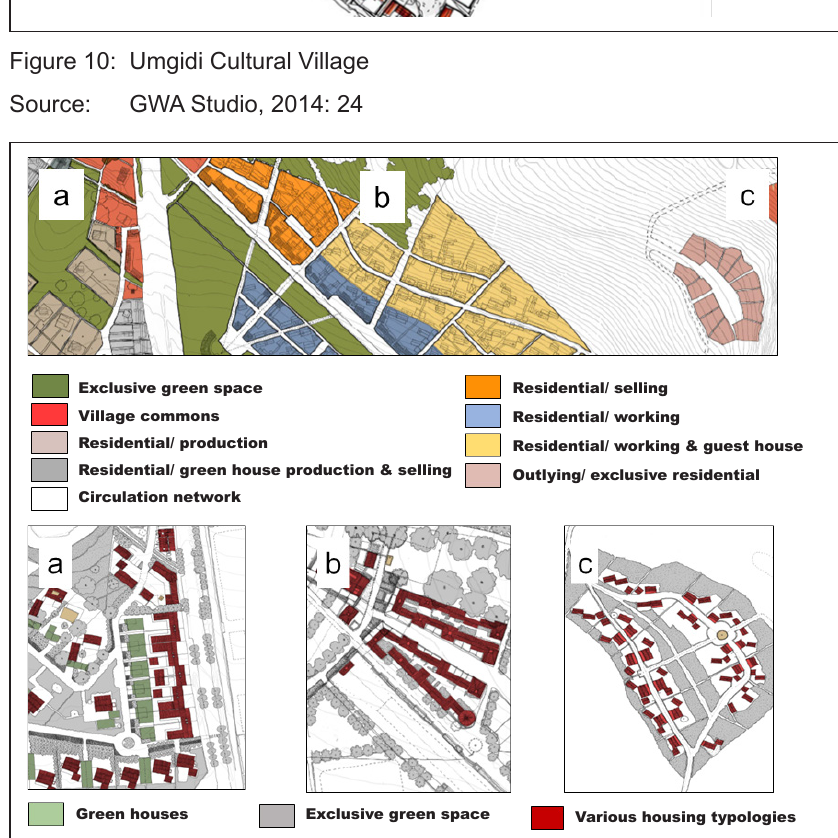
Figure 11: Density transect from (a) higher density residential village living/commercial/production; (b)